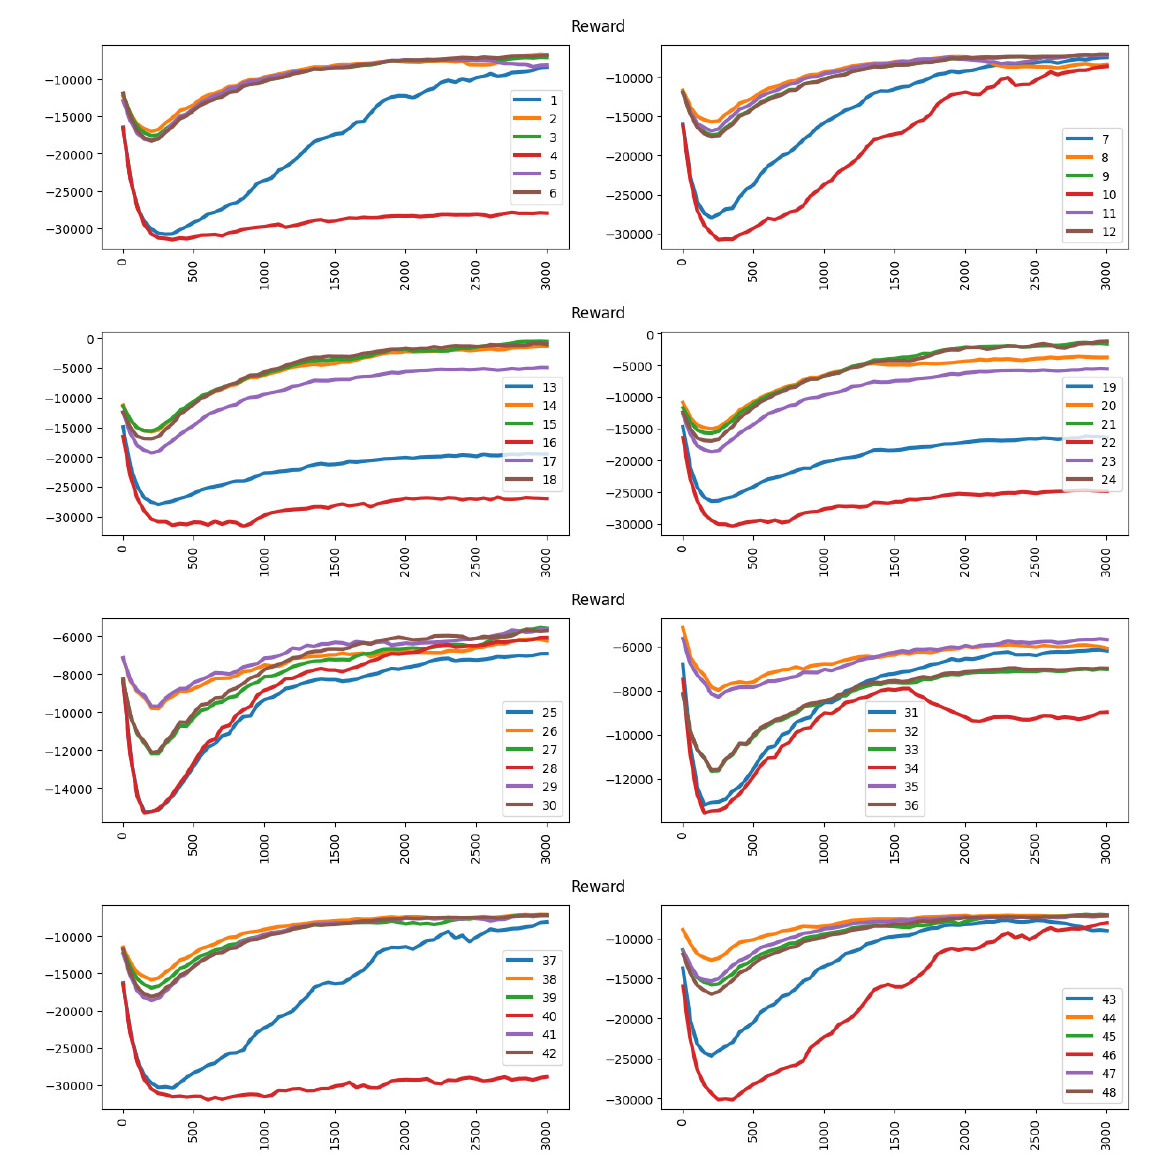
Figure 14. Reward result under the occupancy, revenue and vehicle flow regulation (unified) ap-